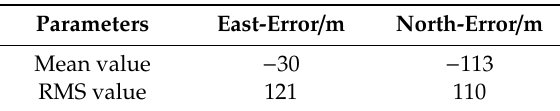
Table 3. Error statistic results of positioning with the primer message signal and height aiding in weak signal